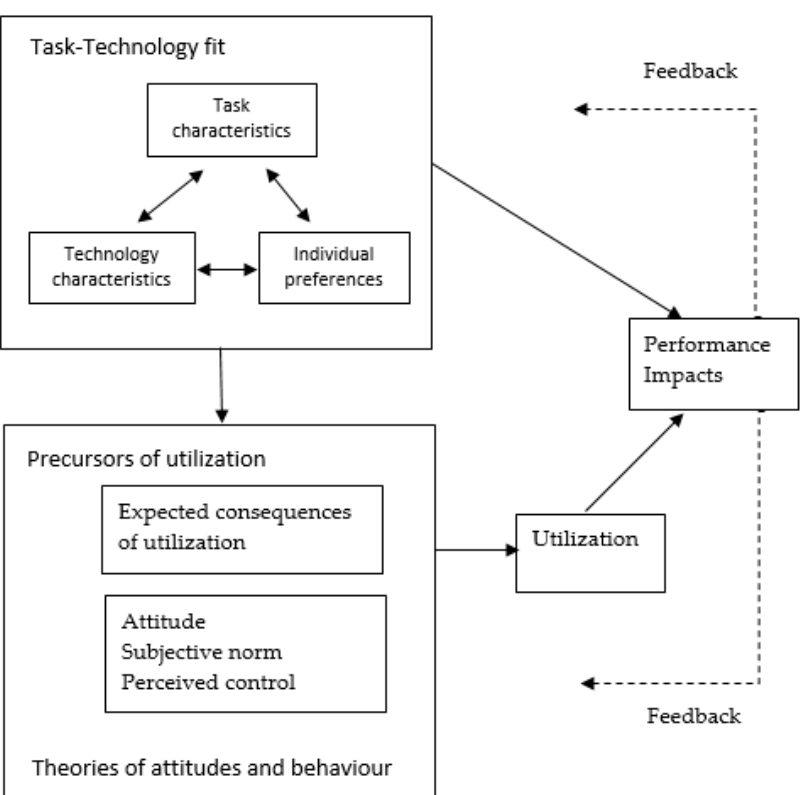
Figure 5. A representation of task-technology fitness theory. Based on Goodhue and Thompson.[17].